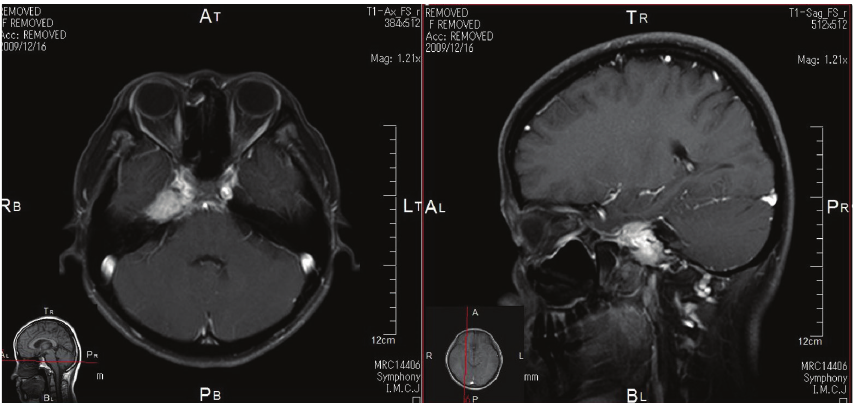
Figure 5: MRI finding of the patient with multiple myeloma who had abducens nerve palsy. MRI images show soft tissue mass enhanced with Ga in the region of the apex of the pyramid.